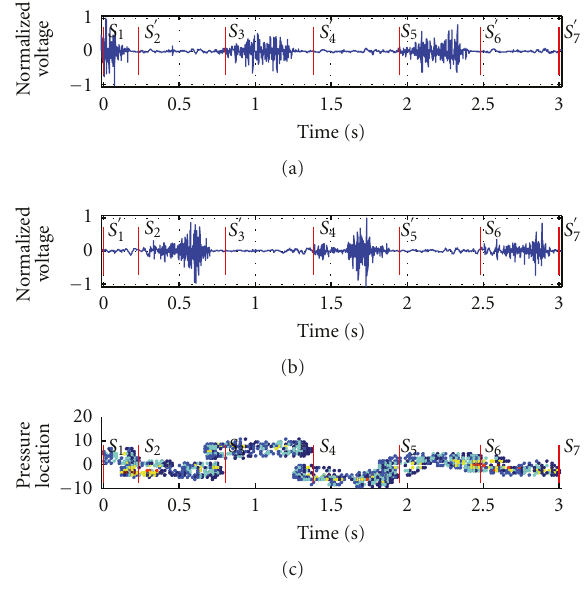
Figure 2: Time-aligned EMG signals of (a) left gastrocnemius (b) right gastrocnemius, and (c) pressure walkway recording, with swing phase divisions shown in